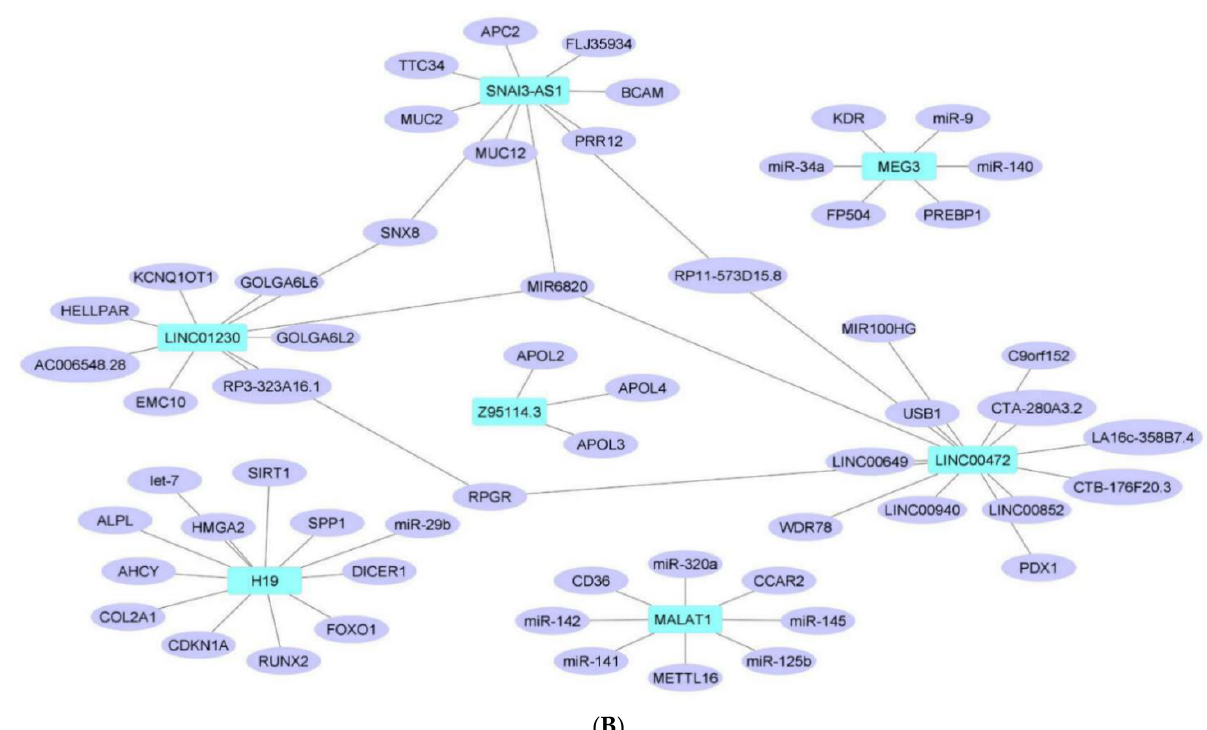
Figure 4. Downregulated human lncRNA networks in diabetes: ( A ) Human lncRNA – lncRNA network: Human lncRNA–lncRNA interaction network with 29 nodes and 406 edges. The networks were constructed using Cytoscape 3.9.1 [84]. ( B ) Human lncRNA – gene target network: Architecture of networks of downregulated lncRNAs implicated in diabetes in humans showing interaction network of lncRNAs with their targets with 65 nodes and 63 edges. The networks were constructed using Cytoscape 3.9.1 [84]. The lncRNA – target interactions were identified by lncRNA2target v3.0 [93] and LncRRIsearch [94].